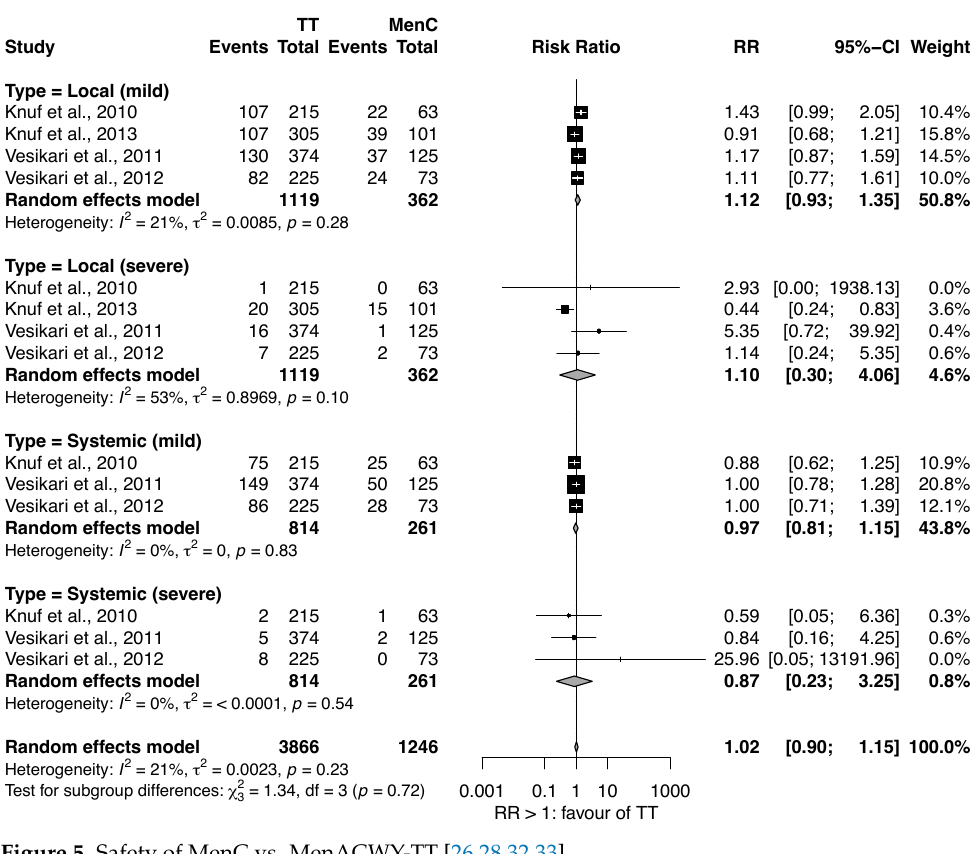
Figure 5. Safety of MenC vs. MenACWY-TT